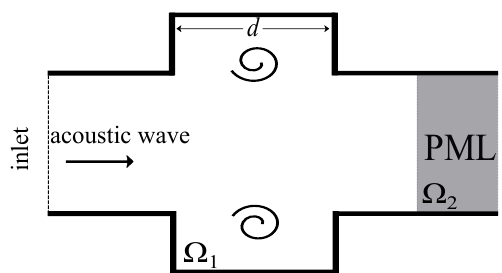
Figure 1. Two-dimensional cavity-duct